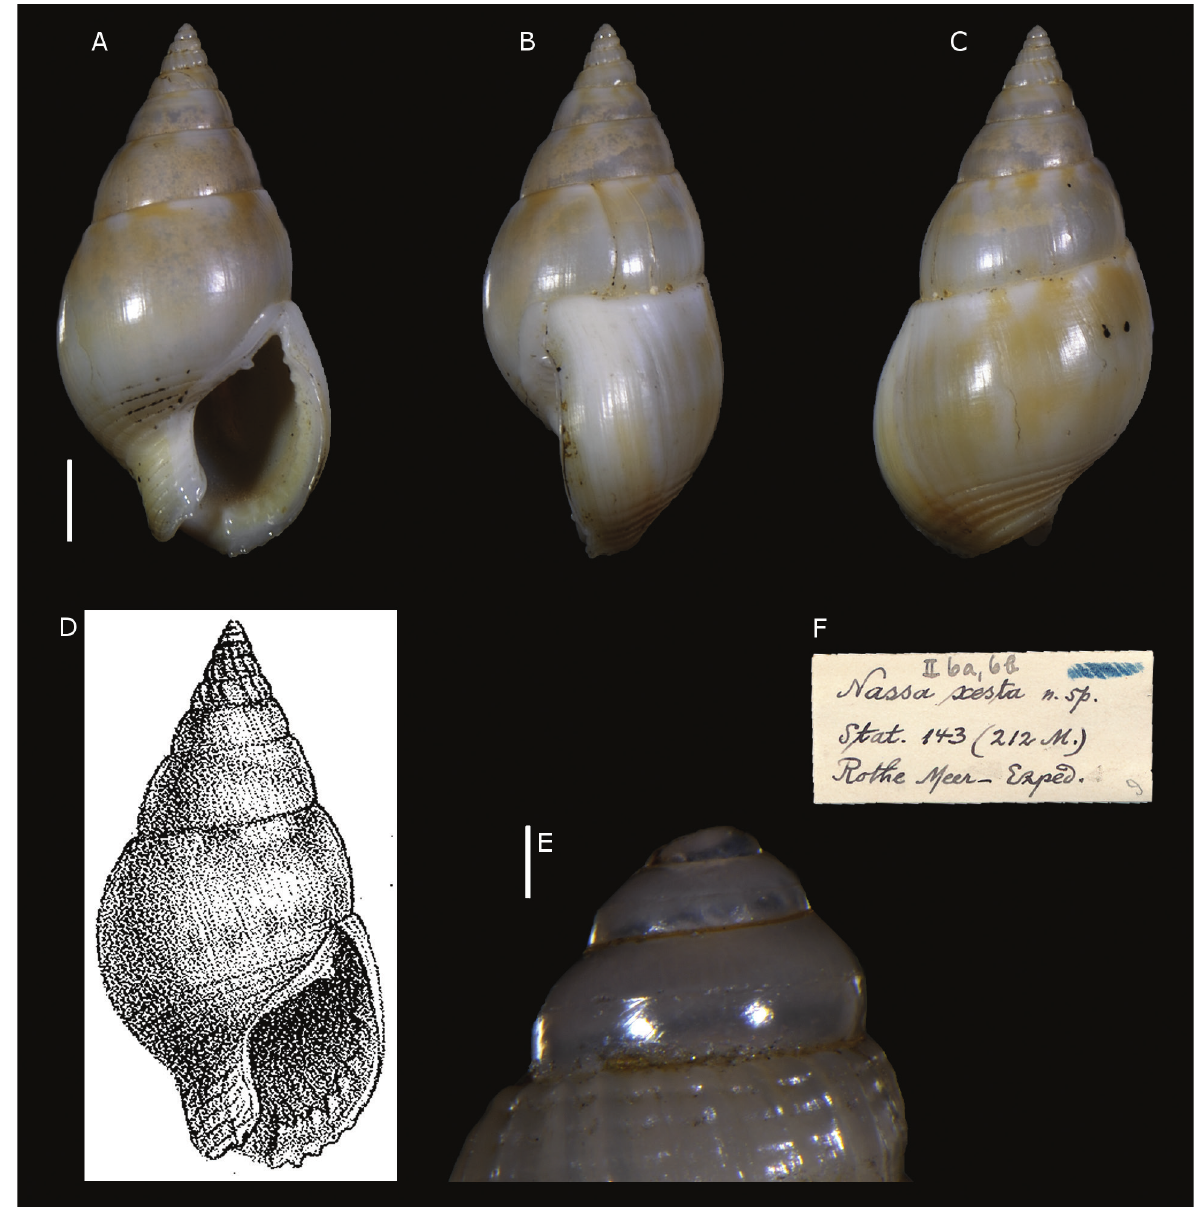
Figure 18. Nassa xesta Sturany, 1900, Station 143 (Harmil Island, Dahlak Archipelago, Eritrea, Red Sea). A–C, E . Holotype, NHMW 84189: front ( A ), right side ( B ), back ( C ), protoconch ( E ). D . Original figure by Sturany (1903). F . Original holotype label. Scale bars: A–C : 3 mm, E : 0.2